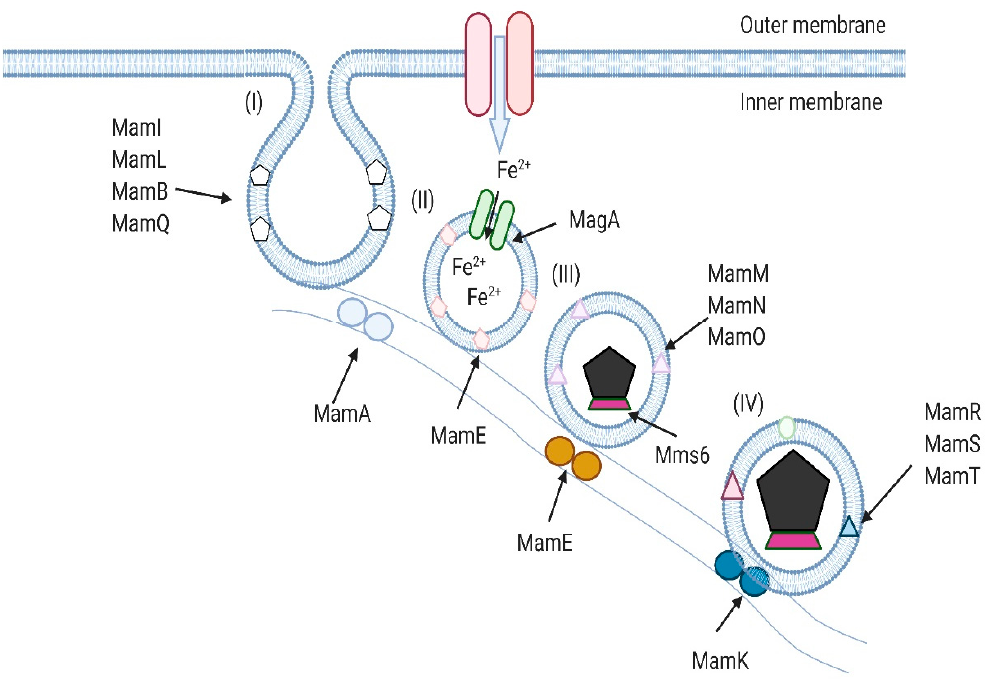
Figure 1. Schematic illustration of the hypothesized mechanism of magnetosome formation (MamA, -B, -E, -K, -L, -M, -N, -O, -Q, -R, -S, -T; Mms6; MagA—proteins involved in formation and maturation of magnetosomes).